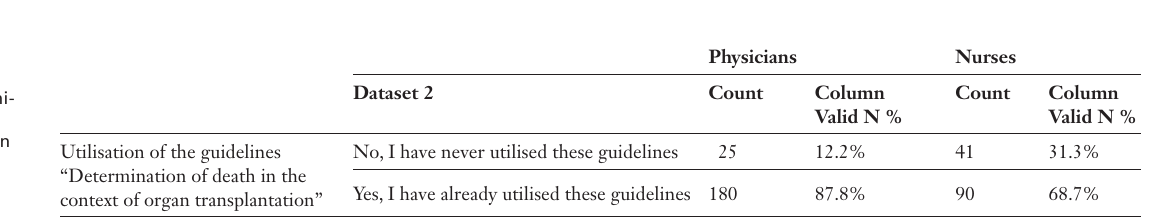
More detailed information on the utilisation of the guidelines “Care of patients in the end of